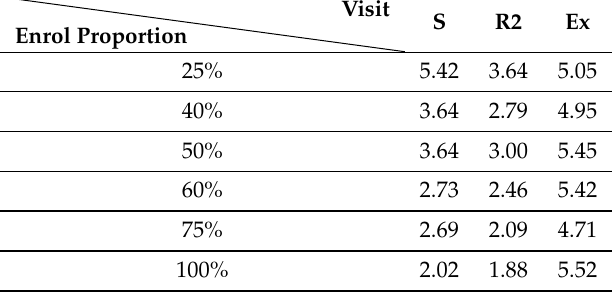
Table 9. EER (%) for different enrolment proportions when using R1 FD for enrolment. Visit Enrol Proportion